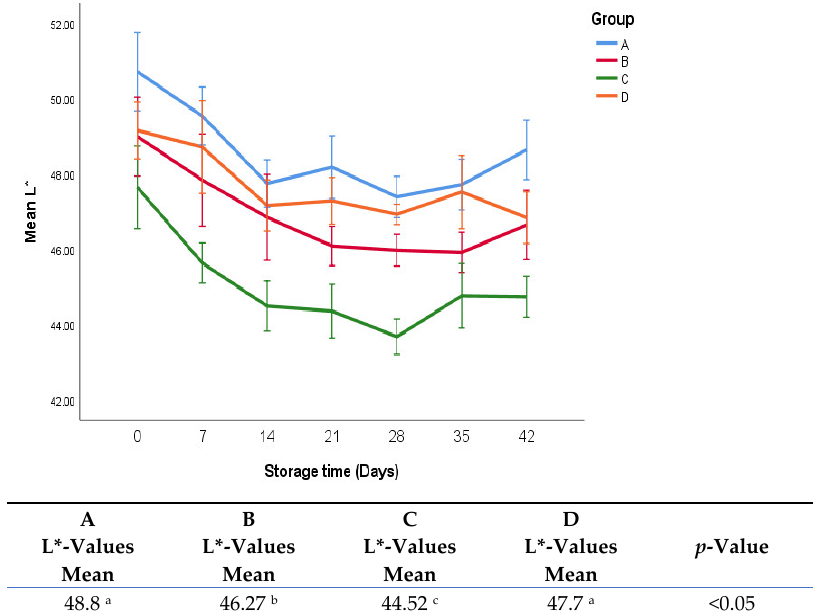
Figure 9. L*-values of fresh oregano at refrigerated temperature 4 °C during storage period (42 days). The significant differences ( p < 0.05) between means are indicated in different letters in the same row. The effect of treatments was pooled to consider the whole storage period and the means were separated by Duncan test.